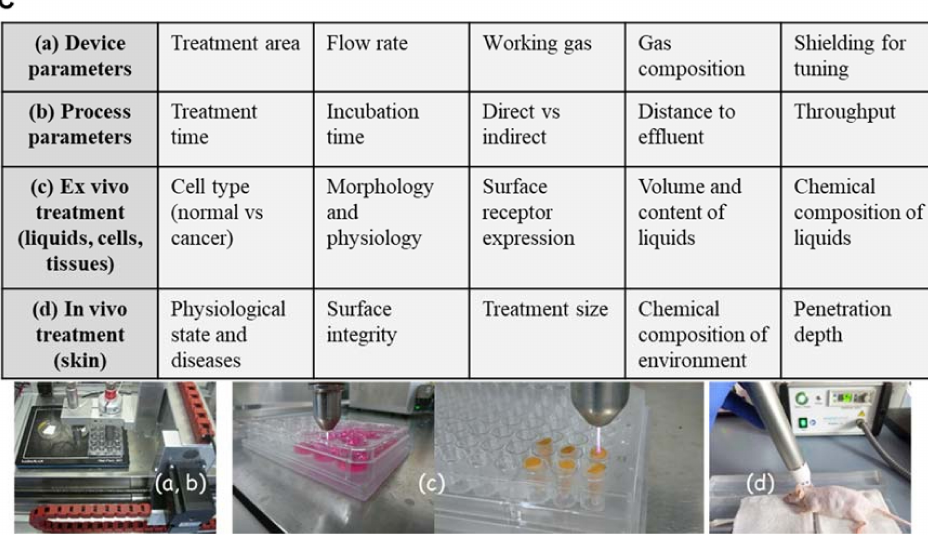
Figure 1. Parameter influencing impact, efficiency and specificity of plasma. ( A ) Cold physical plasma generates reactive oxygen (ROS) and nitrogen species (RNS), which can be delivered to target cells. ( B ) Optical emission spectroscopy resolves, for example, OH (~308 nm) and the second positive system of molecular nitrogen (315–380 nm, upper diagram) as well as other excited species such as atomic O (777 nm and 844 nm) and atomic Ar in the range of 696 and 912 nm (lower diagram). ( C ) Device parameters such as treatment area, flow rate, working gas, components of gas and their tuning ( a ) as well as process parameter including treatment and incubation time, direct vs. indirect treatment, distance to the effluent and throughput can be modulated. Plasma is used to treat liquids ( b ), cells or tissues ( c ) or can be applied in vivo directly to the skin ( d